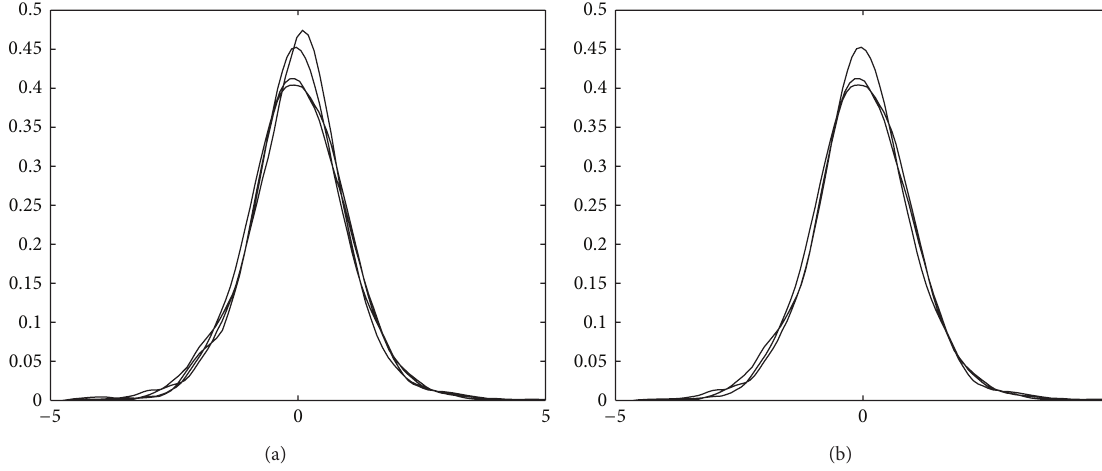
Figure 3: Standardized densities of (1,3,4,8) (a) and of (3, 4,8) (b) for the last 𝑛 = 904 observations in the Oil currency data set. 𝐸{̃ F (𝑥)} = Υ 󸀠 {𝐸( F (𝑥))} = 0 . Moreover, by Gaussian and F